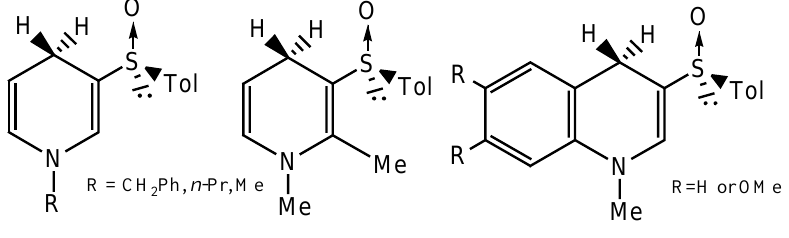
Figure 1 . The structures of three chiral sulfoxide coenzyme NADH model compouds.